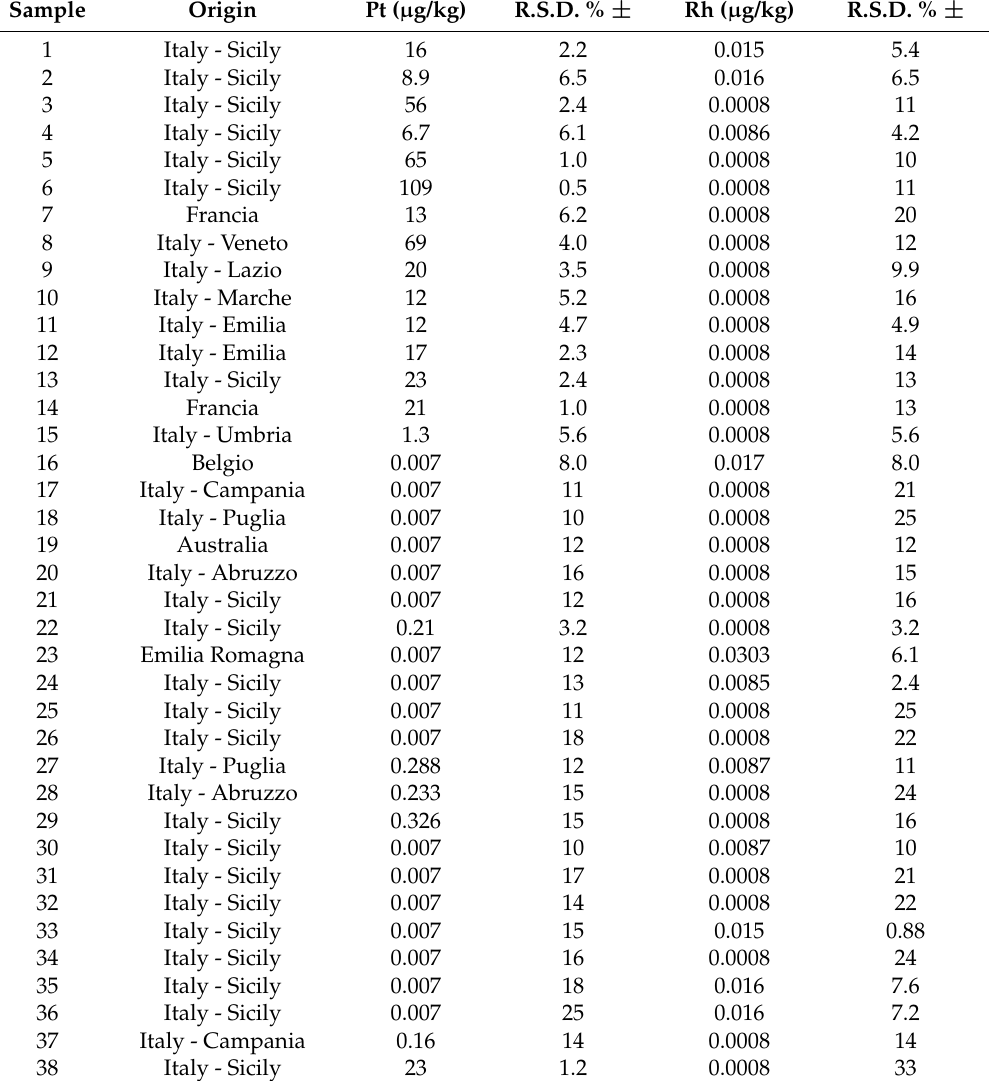
Table 3. Platinum and rhodium concentrations in potato